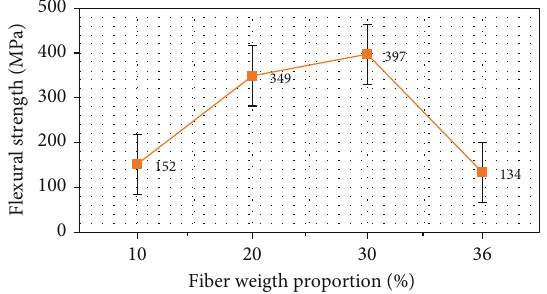
Figure 7: E ff ect of fi ber weight proportion on fl exural property.